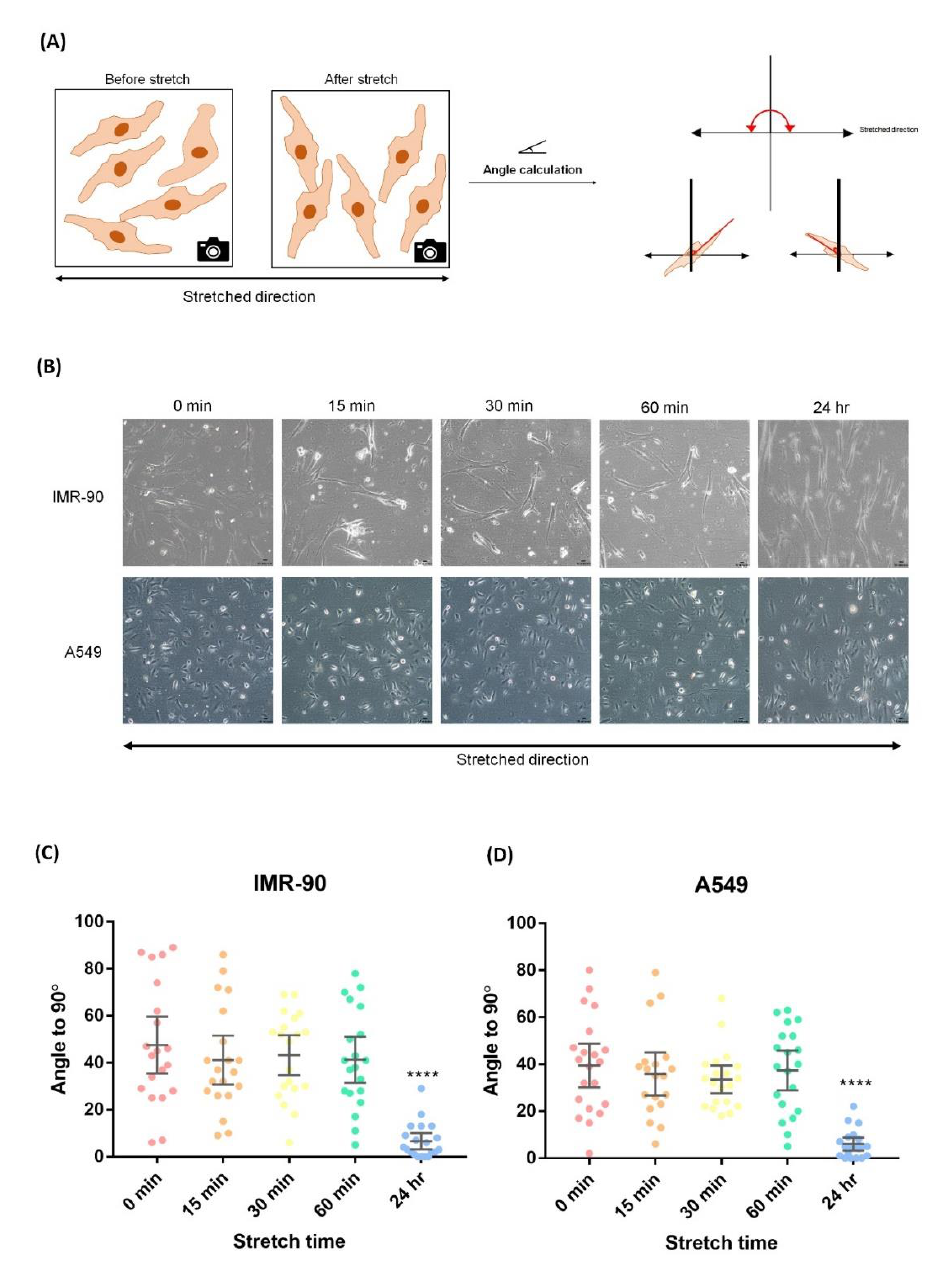
Figure 5. Image-based quantification of cyclic stretching-induced cellular rearrangement. ( A ) Schematic of the angle quantification process. The angle was between 0 ◦ and 180 ◦ with respect to the axis of stretch. ( B ) Cells subjected to di ff erent periods (0, 15, 30, 60 min and 24 h) of stretching. The arrow indicates the direction of stretching. ( C , D ). Scatter plot of the orientation of IMR-90 and A549 cells after di ff erent periods of cyclic stretching. The angle was measured between 0 ◦ and 180 ◦ with respect to the axis of stretching then 90 ◦ was subtracted and the absolute value was taken, which indicated the angle to the vertical. Twenty cells from each time period were selected for the measurement. The angle of the two cell lines were distributed evenly before stretching and moved to be vertical to the stretching direction after 24 h of stretching. An unpaired two-tailed Student’s t -test was used, where a p -value < 0.05 was considered as a significant change.